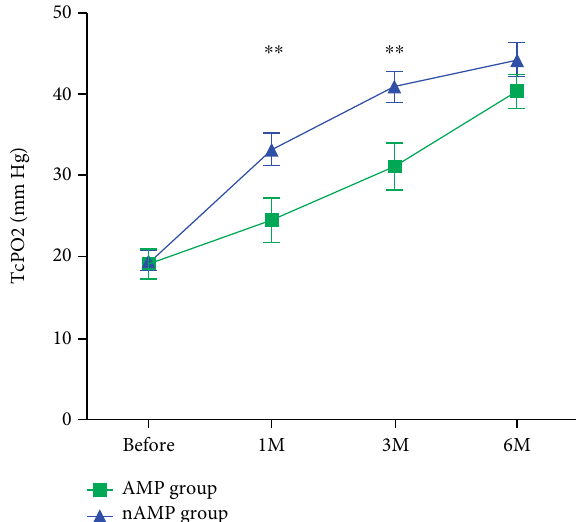
Figure 3: TcPO in the AMP and nAMP groups up to 6 months 2 after ACT. ∗∗ represents a signi fi cant di ff erence between the AMP and nAMP groups in 1 month and 3 scores (AMP 3.8 vs. nAMP 3.7, NS) and SINBAD scores (AMP 4.1 vs. nAMP 4.1) were not di ff erent between the AMP and nAMP groups at baseline (Table 1).